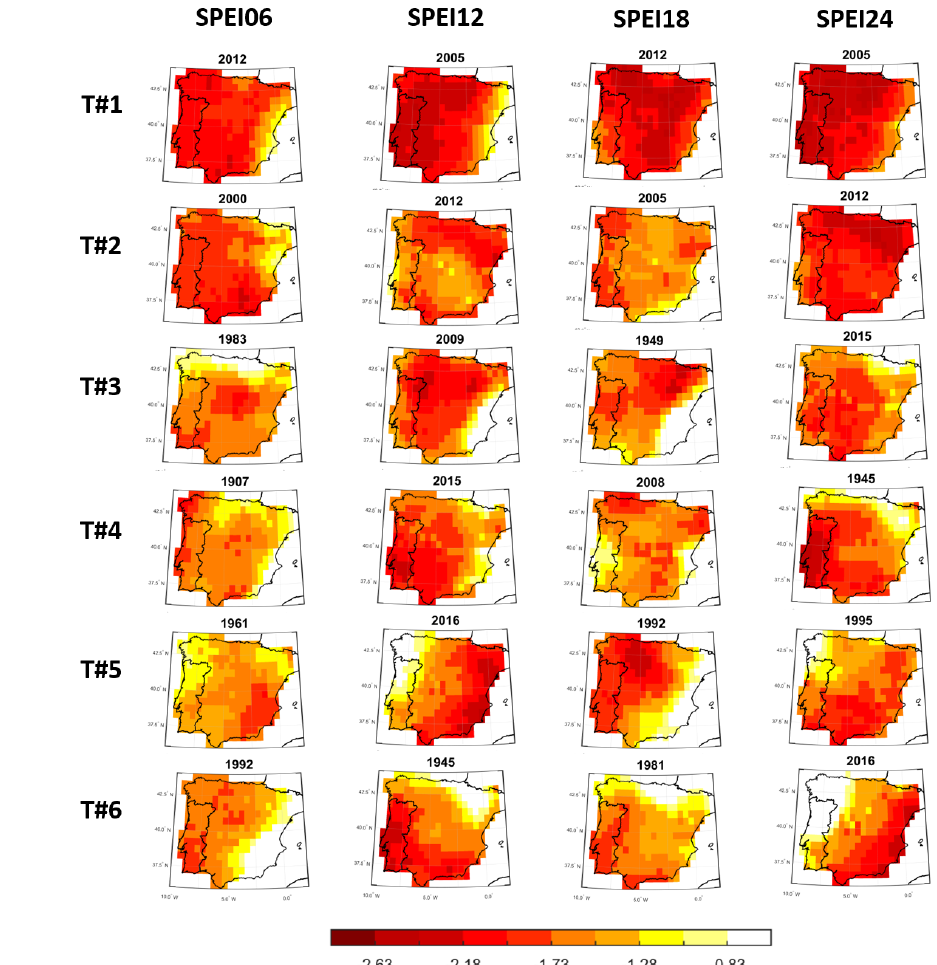
Figure 2. The top 6 drought events in the Iberian Peninsula domain for the 6-month timescale SPEI for March (2012, 2000, 1983, 1907, 1961, and 1992; first column), the 12-month timescale SPEI for September (2005, 2012, 2009, 2015, 2016, and 1945; second column), the 18-month timescale SPEI for March (2012, 2005, 1949, 2008, 1992, and 1981; third column), and the 24-month timescale SPEI for September (2005, 2012, 2015, 1945, 1995, and 2016; fourth